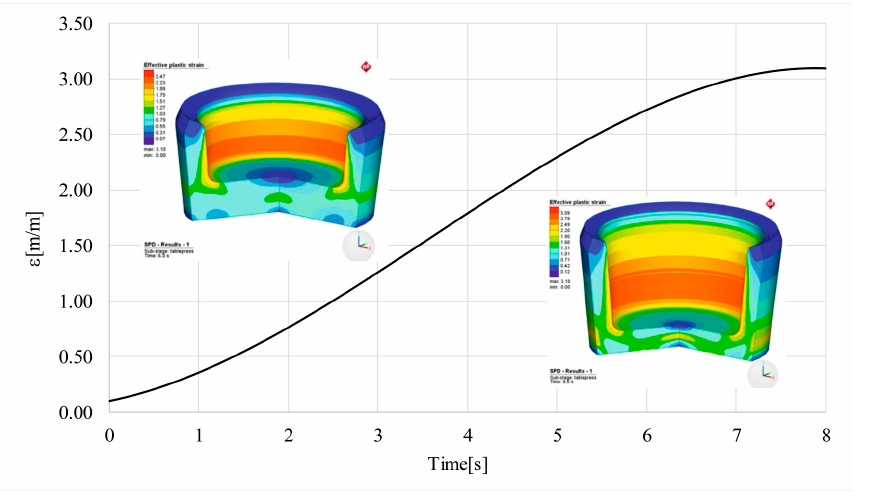
Figure 9. HSHPT strain.